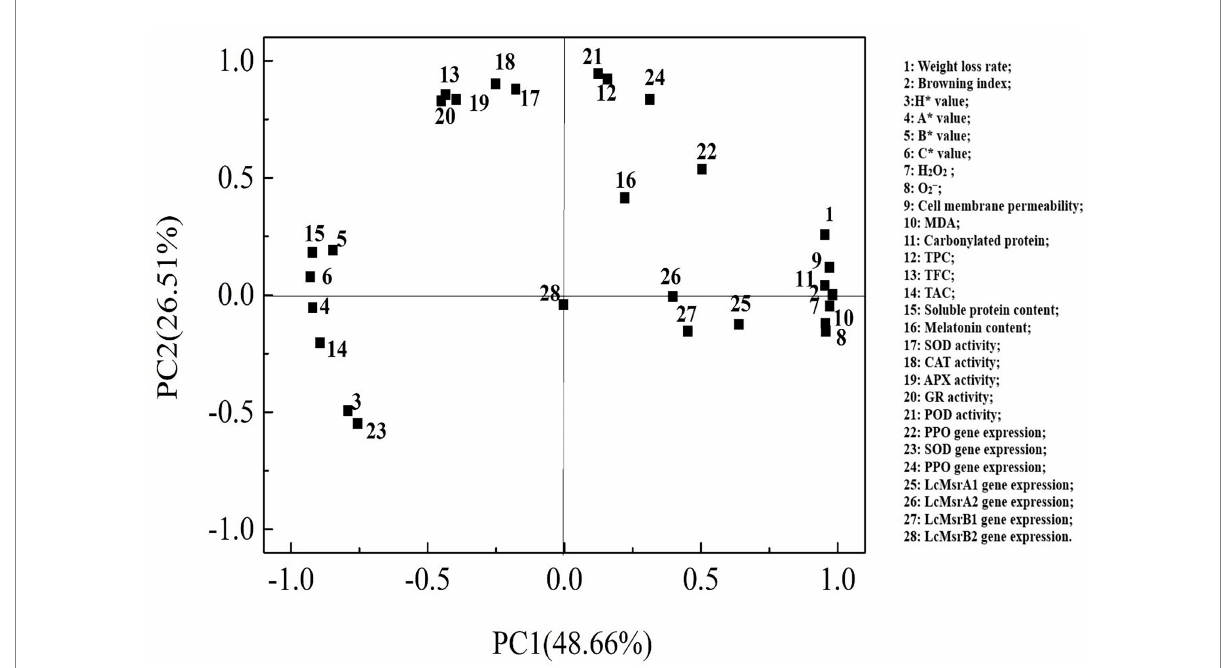
FIGURE 8 Factor loading diagram of physiological indexes of the control, 0.2, and 0.6 mmol·L -1 melatonin-treated samples on 0, 3, 6, 9, and 12 days of the cold storage.